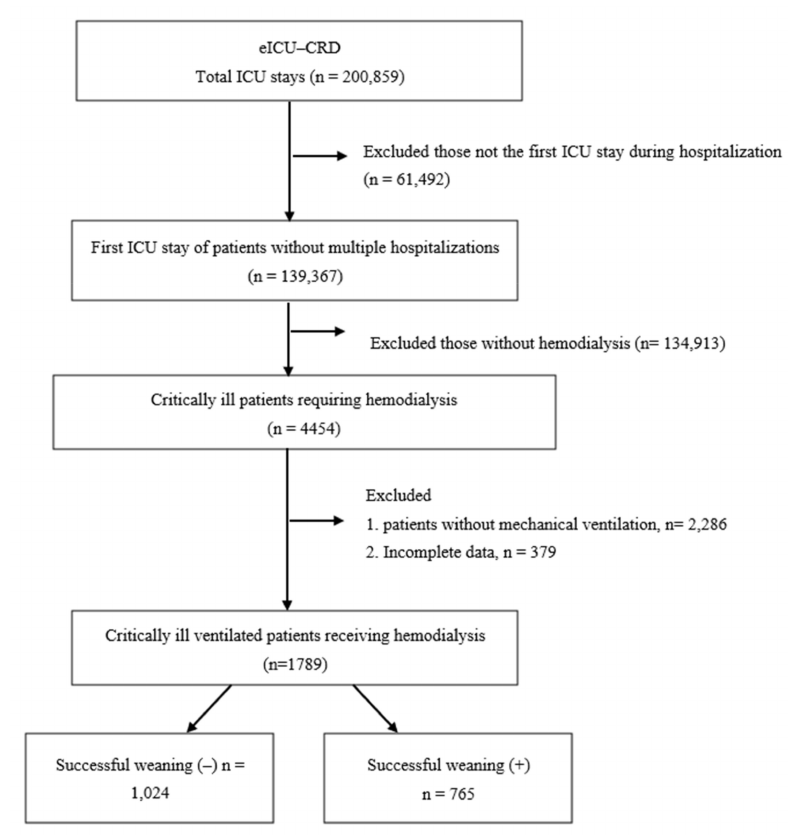
Figure 1. Flowchart showing the selection of critically ill ventilated patients receiving hemodialysis from the eICU Collaborative Research Database. Patients were excluded if they had multiple hospitalizations or if the current ICU stay was not their first. The number of patients who were successfully weaned from mechanical ventilation is shown. Abbreviations: eICU-CRD, eICU Collaborative Research Database; ICU, intensive care unit; (+), successful weaning from mechanical